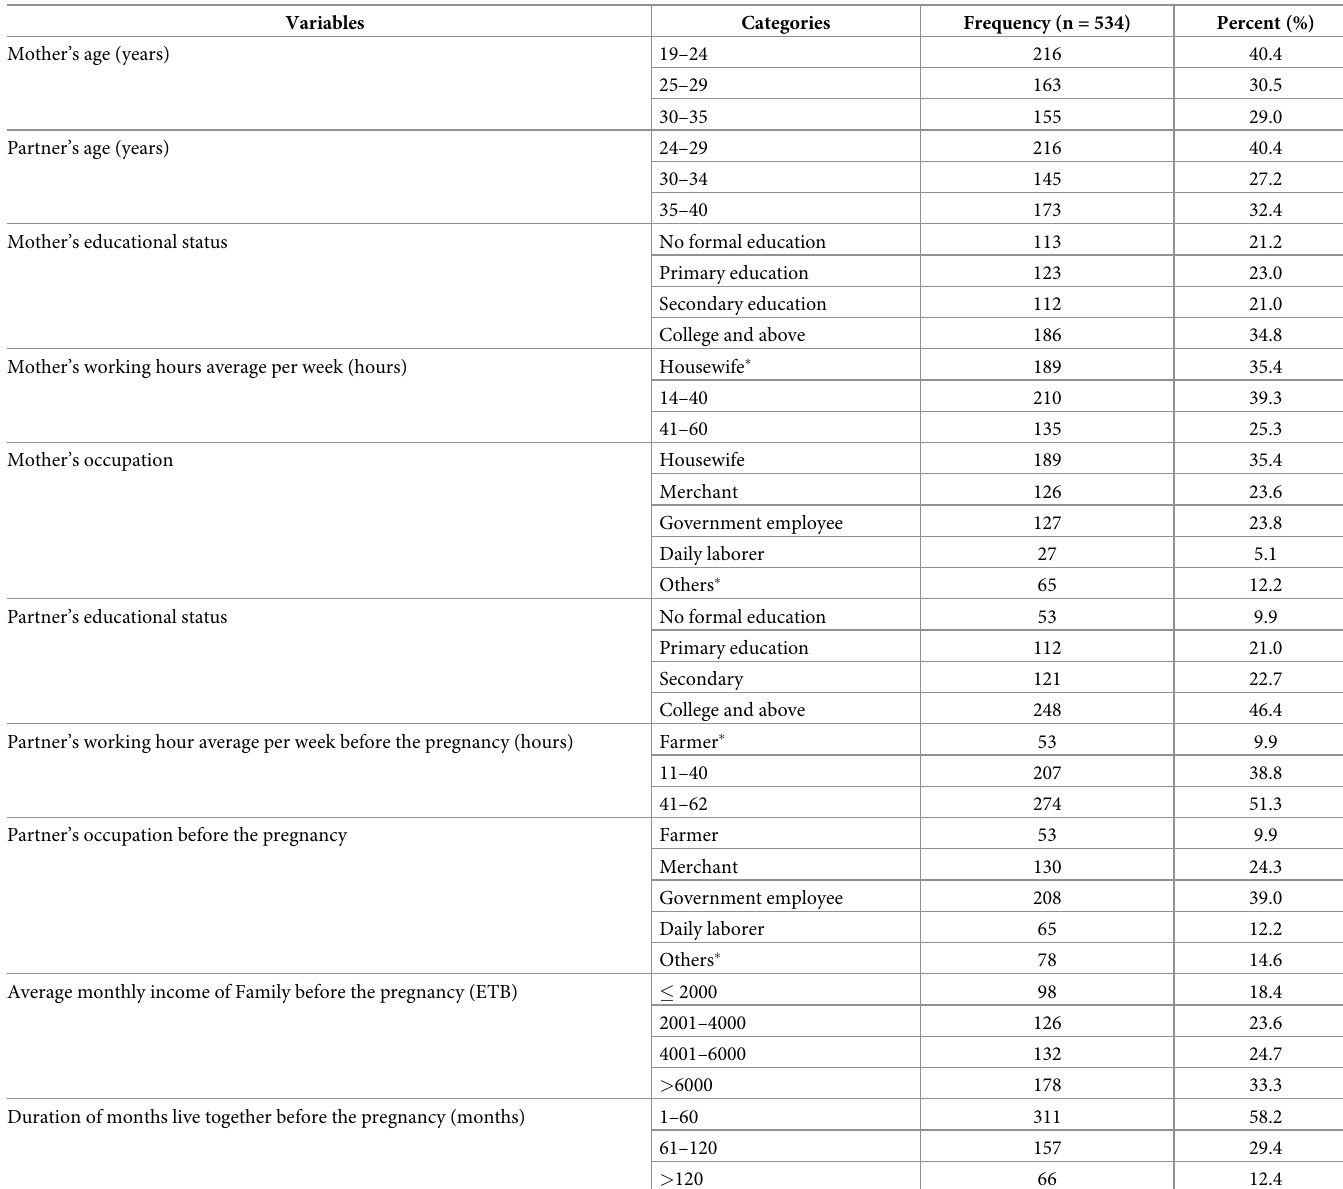
Table 1. Socio-demographic characteristics of mothers with natural planned conception attended ANC service at AMHFs,